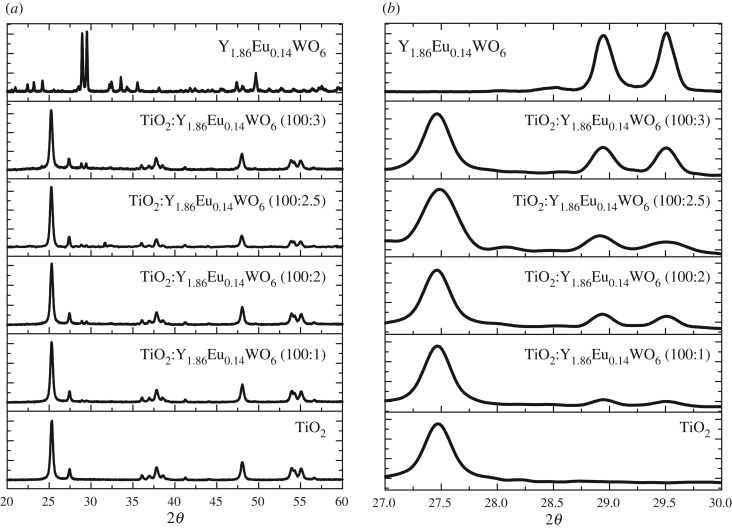
(a) XRD patterns of TiO2 mixed with different content of Y1.86Eu0.14WO6. (b) XRD patterns in the 2θ region of 27--30°.